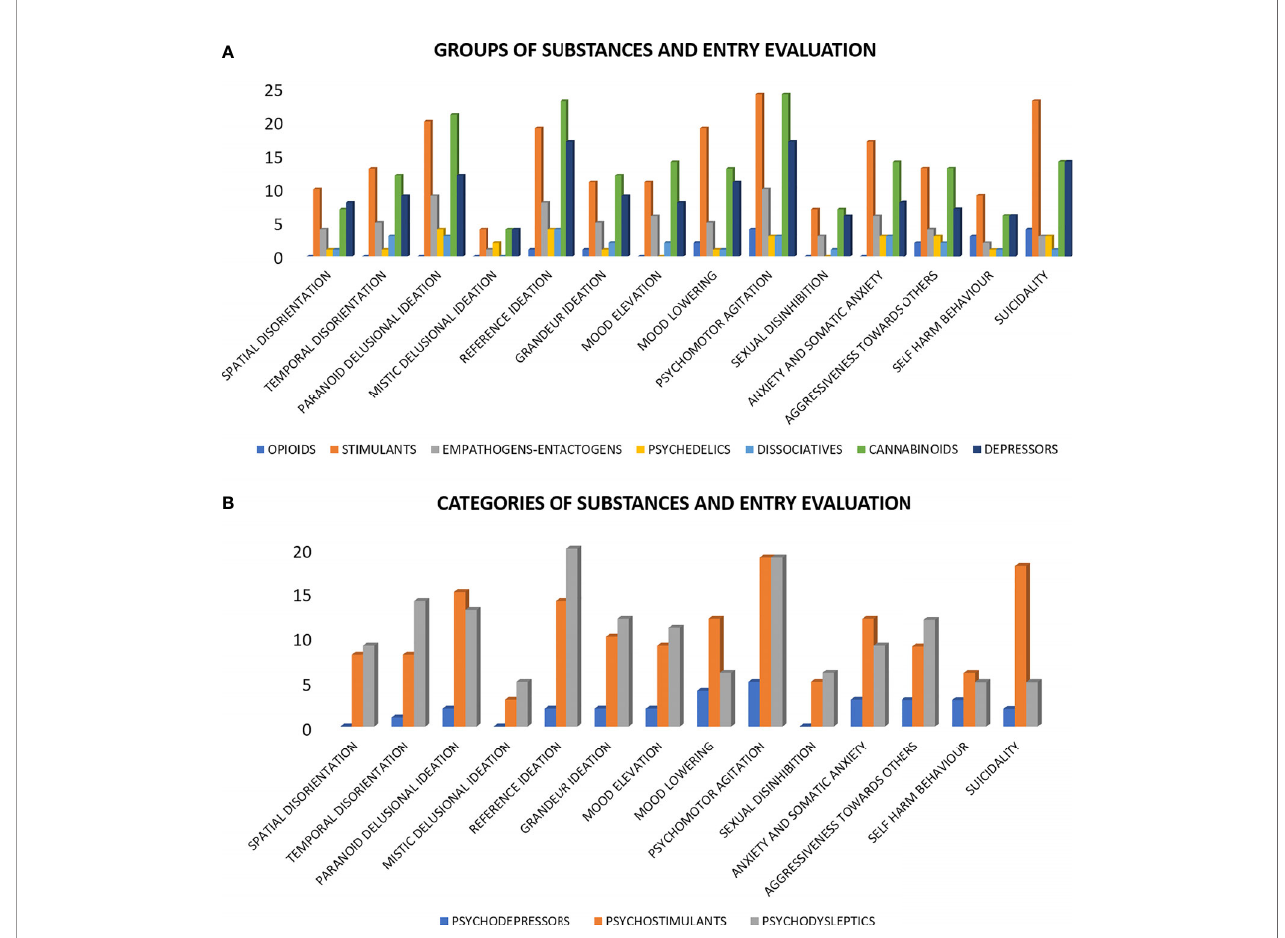
FIGURE 1 | Entry evaluation distribution according to groups and categories of substances. (A) Entry evaluation distribution according to the following groups of substances: opioids, stimulants, empathogens-entactogens, psychedelics, dissociatives, cannabinoids, and depressors. (B) Entry evaluation distribution according to the following categories of substances: psychodepressors, psychostimulants, and